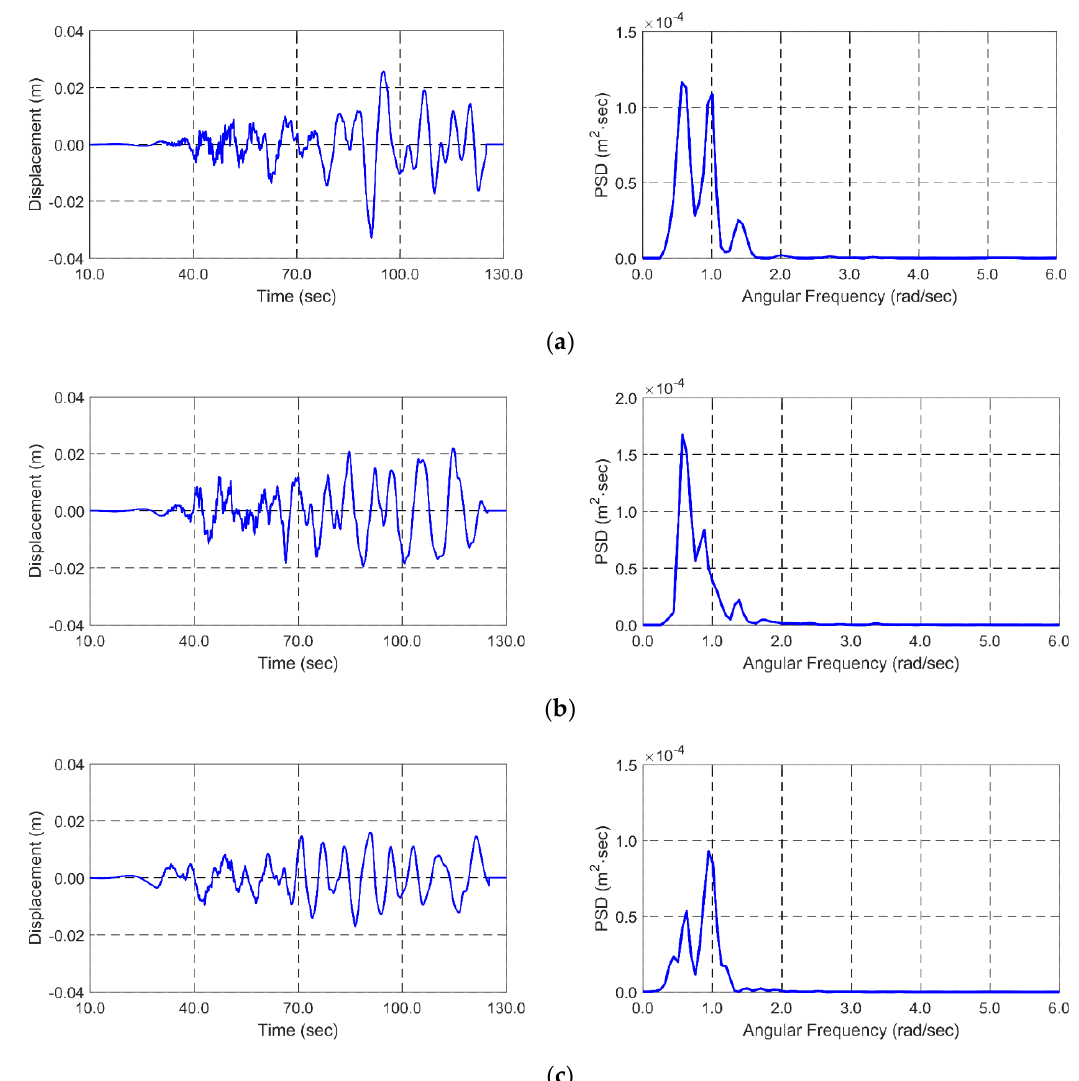
Figure 4. Time histories of real seismic excitations in longitudinal = x ( a ), transverse = y ( b ), and vertical = z ( c ) directions and its corresponding spectra.